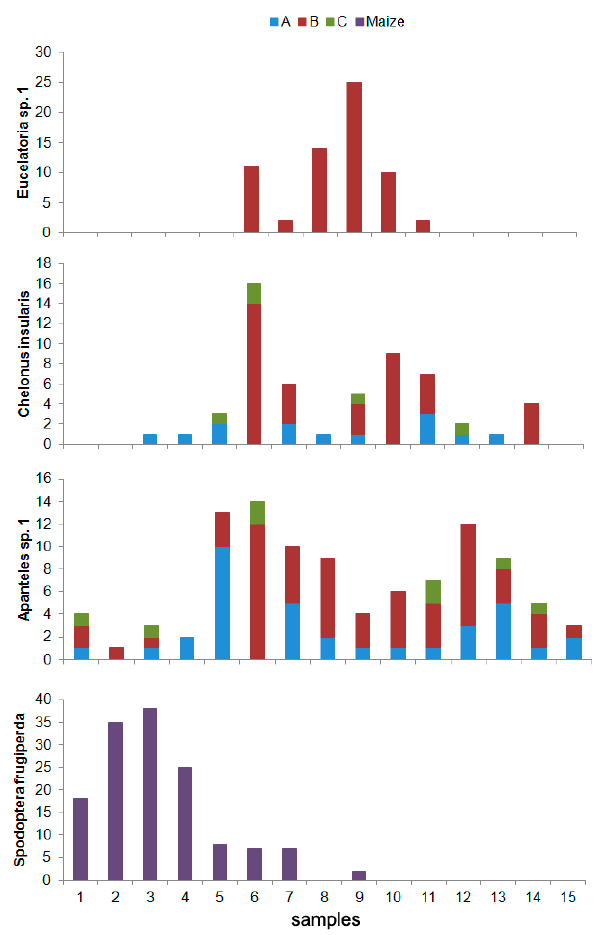
Figure 4. Abundance of Spodoptera frugiperda and the three parasitoid species reported as its enemies during the sampling period in each refuge.